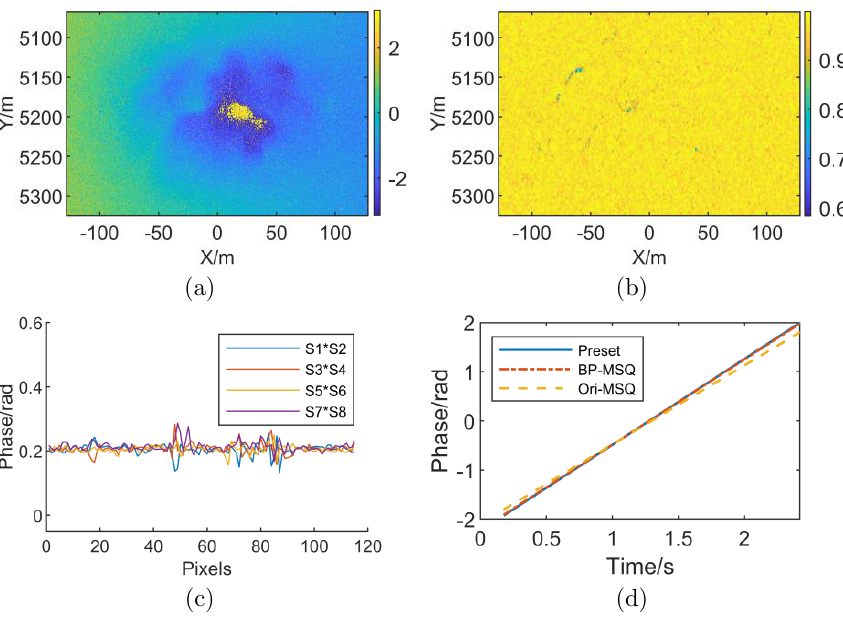
Figure 5. Stripmap SAR simulation results with linear RME. ( a ) Interferometric phase with linear RME; ( b ) Coherence map with linear RME; ( c ) Subaperture differential interferometric phase (’S1’ denotes the subaperture 1, and so forth); ( d ) Comparison of preset value and estimation result of RME